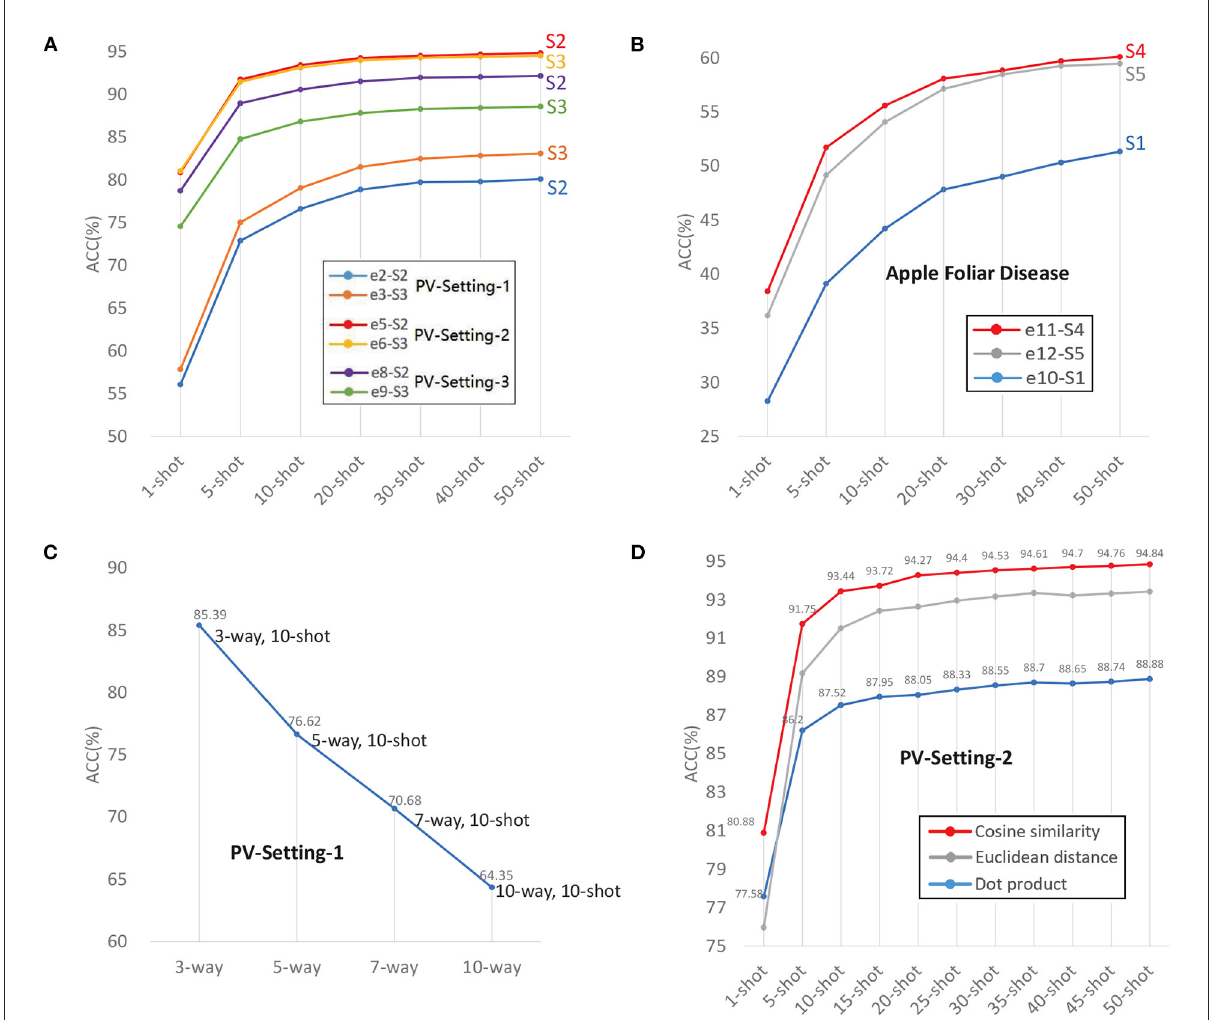
FIGURE5 (A) Intra-domain experiments with three data settings. (B) Cross-domain experiments with AFD. (C) The accuracy decreases as Way increases. (D) Distance